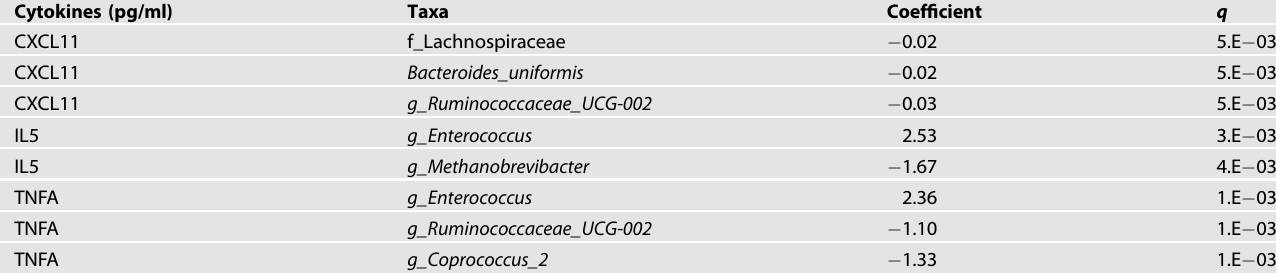
Table 5. Signi fi cant associations between cytokines levels and ASV composition during the second trimester. Cytokines (pg/ml)